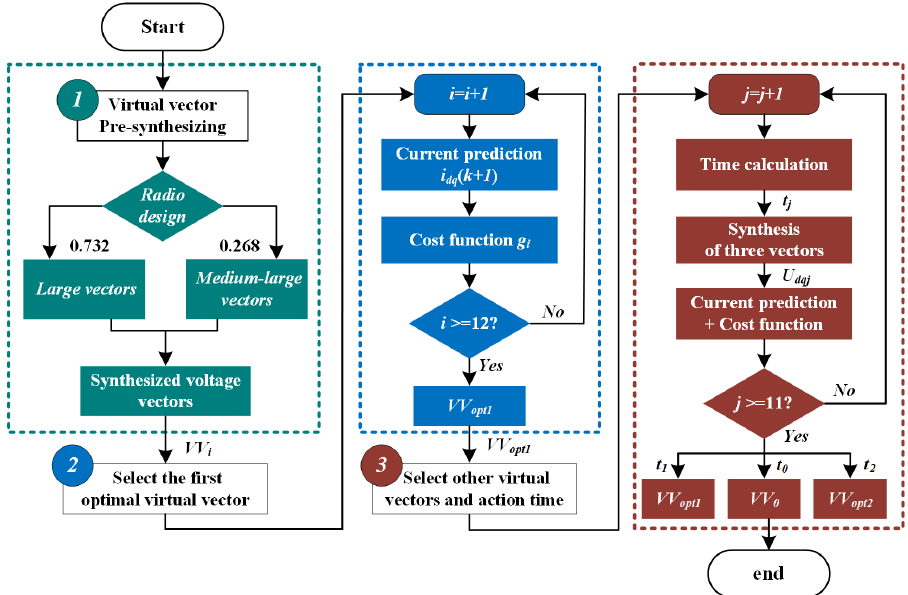
Figure 7. Flowchart of proposed MVV-MPC.